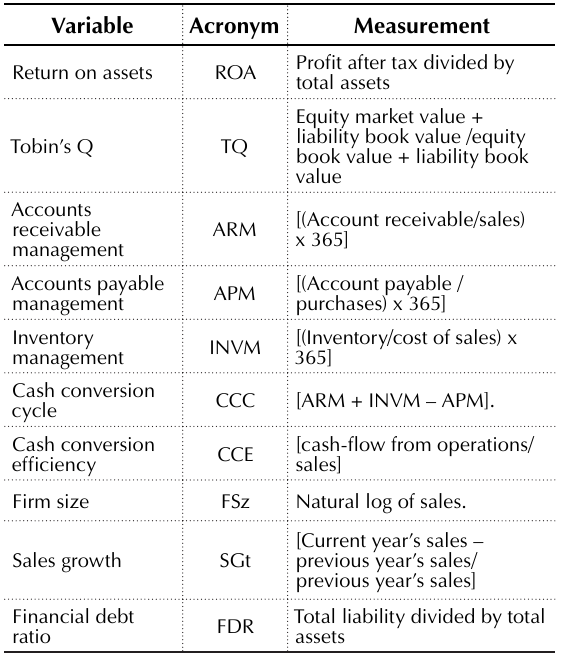
Table 2. Summary of variables and